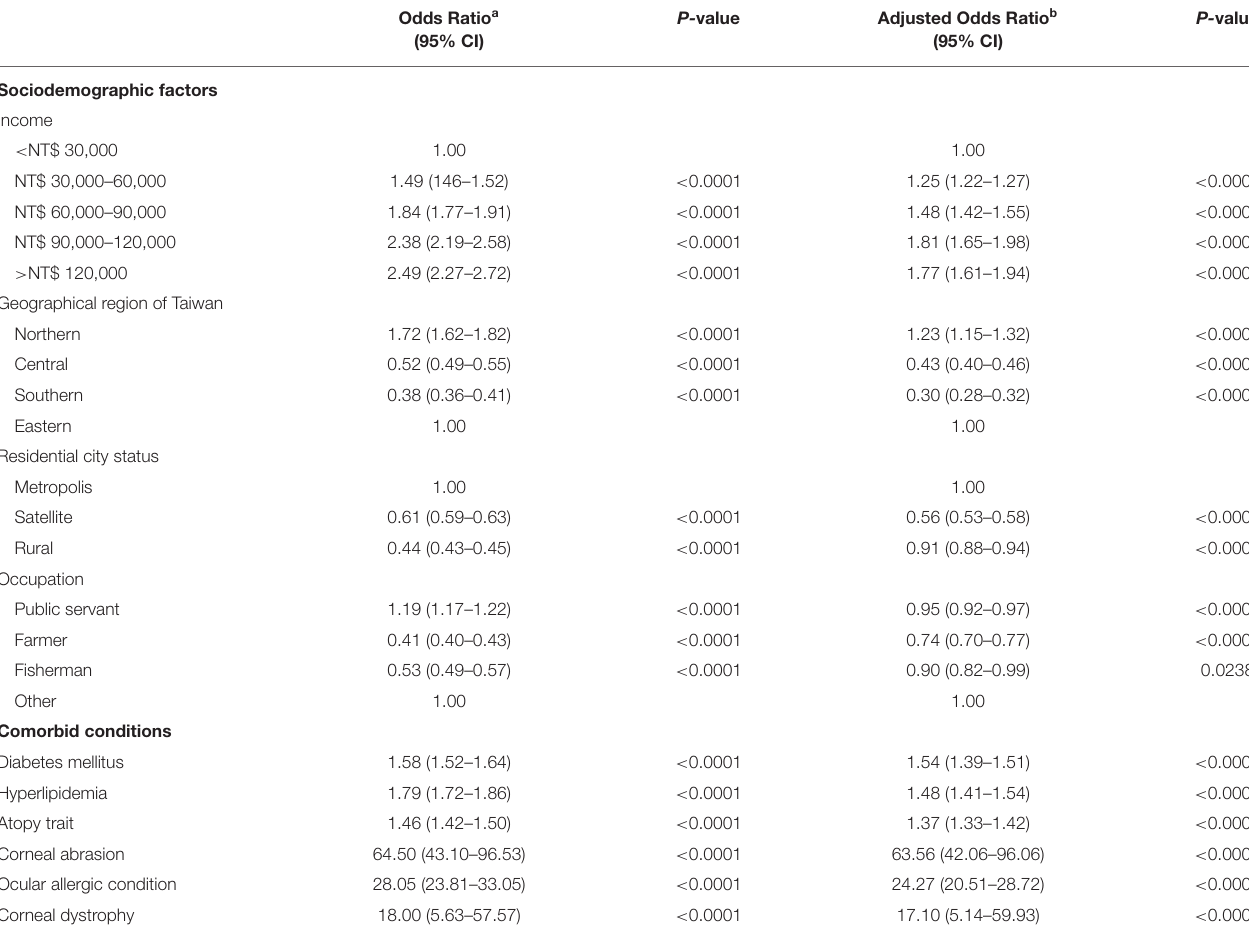
TABLE 2 | Odds ratios and adjusted odds ratios for various sociodemographic factors and comorbid conditions with recurrent corneal erosion. Odds Ratio